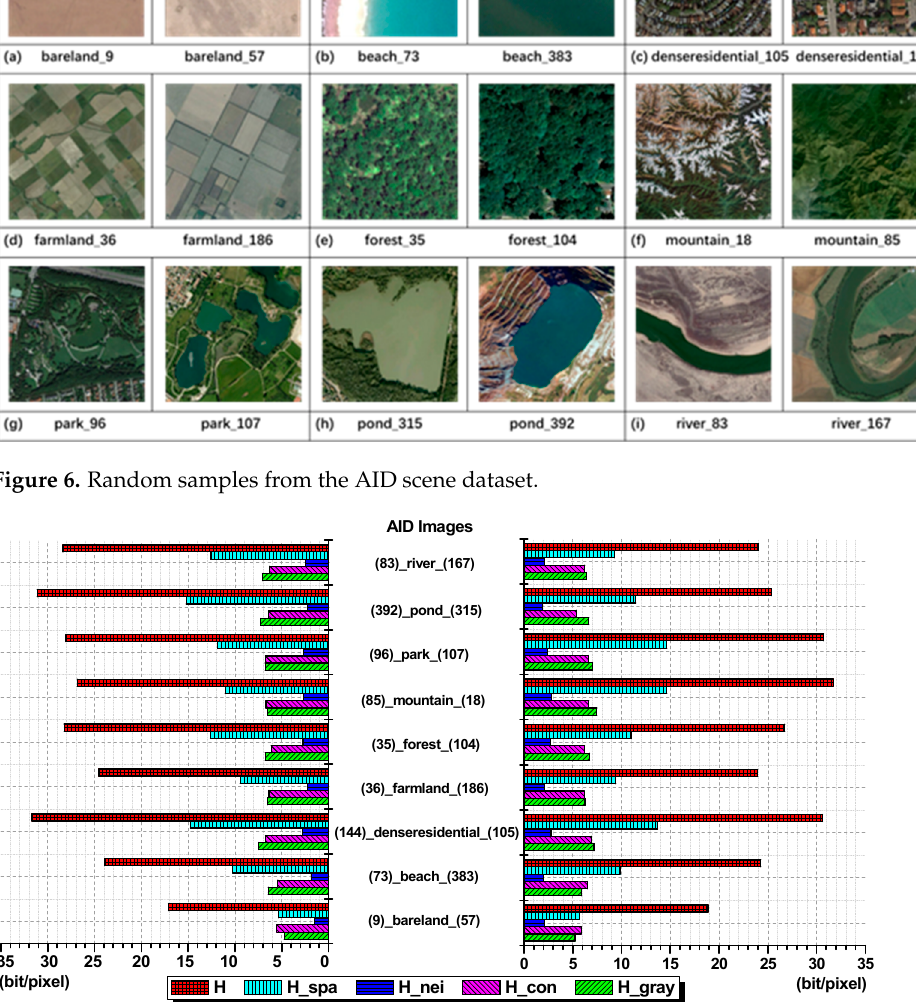
Figure 7. The information content of the various feature levels of AID images.